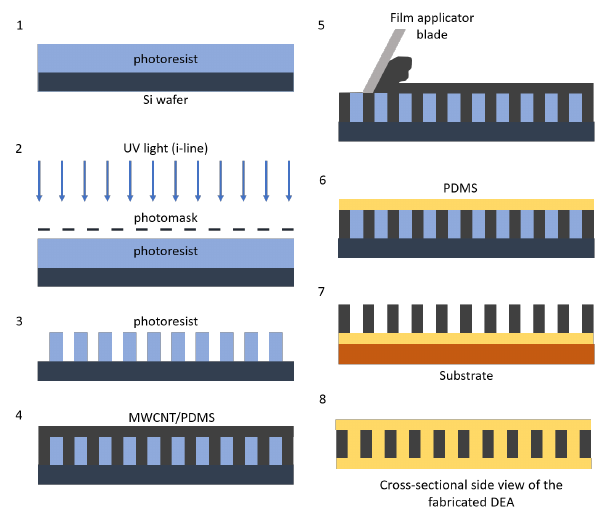
Figure 8. Schematics for the process flow for Method II. Conductive layers are fabricated before the dielectric